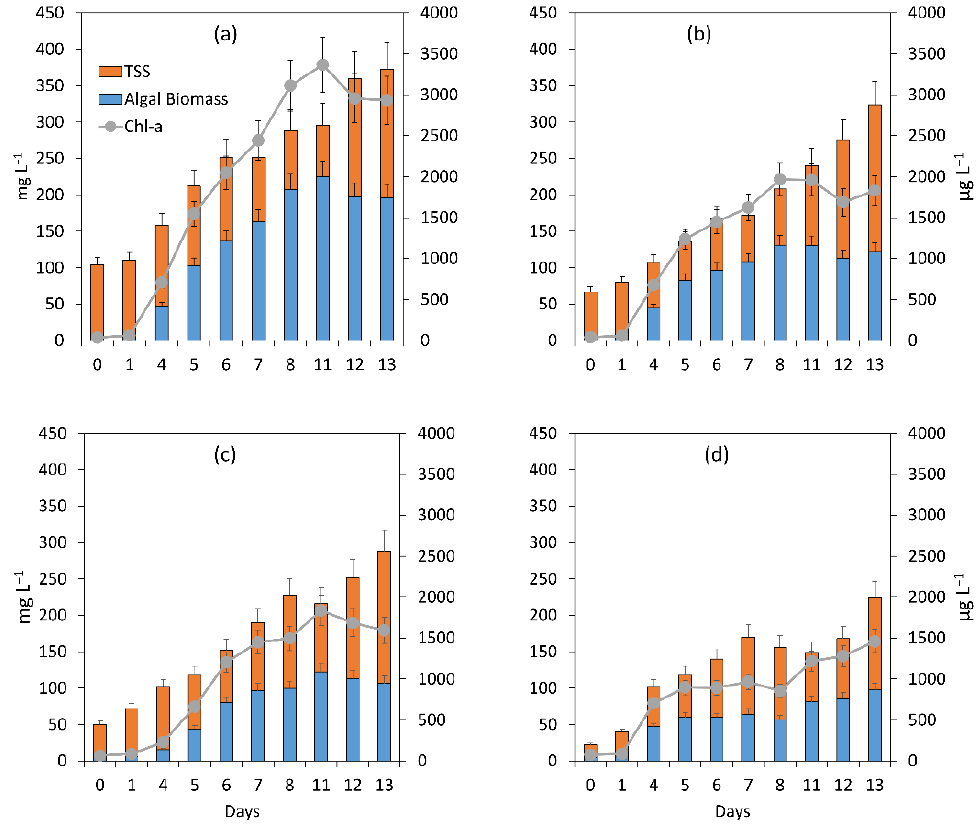
Figure 4. Biomass evolution including TSS, microalgal biomass (mg L − 1 ) and Chl-a ( µ g L − 1 ) under the impacts of light and nutrient load. ( a ) HL.X5, ( b ) HL.X10, ( c ) LL.X5 and ( d ) LL.X10.